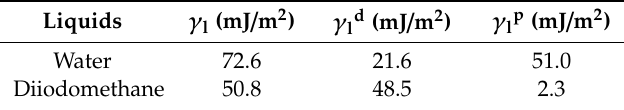
Table 2. Physical characteristics of liquids